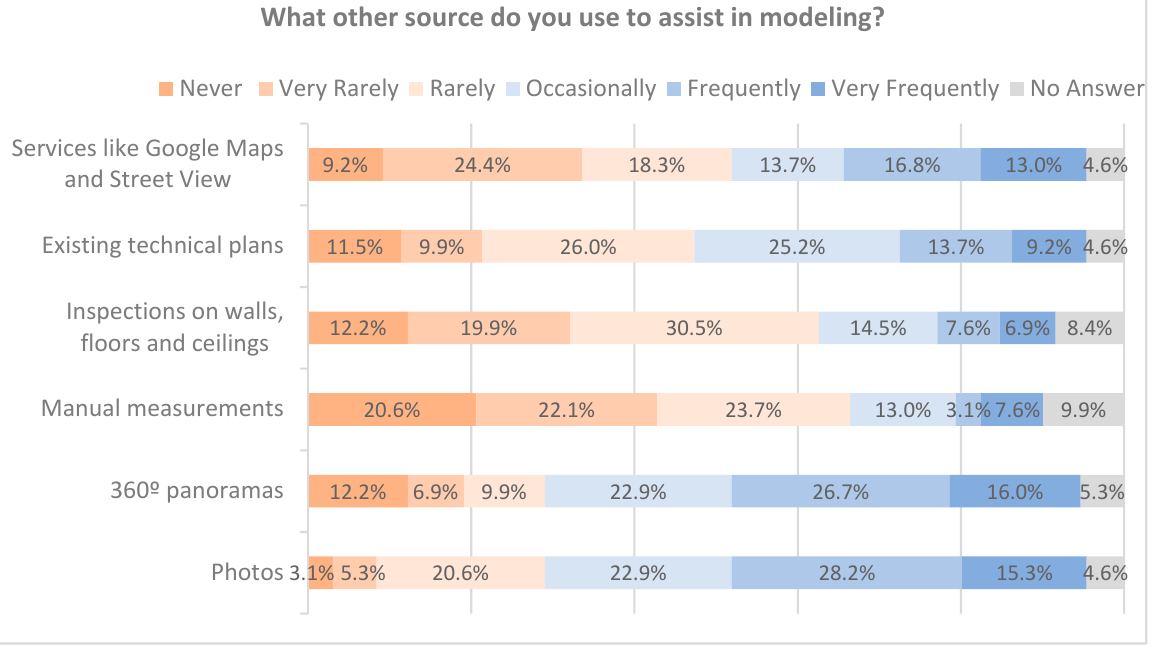
Figure 19. ( a ) Digital tools used in BIM modeling, ( b ) complementary digital tools used to assist the modeling phase.